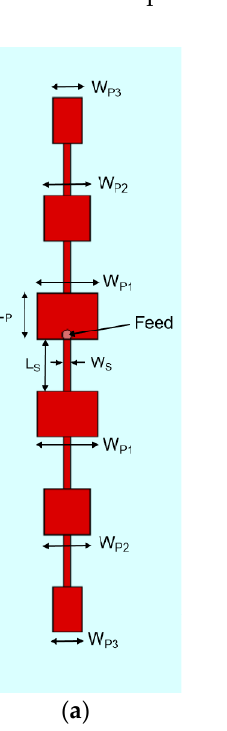
Figure 6. Measured (meas) and simulated (sim) sca tt ering parameters of the array antenna system. The ADSimPLL software [37] was used to design the chirp shape and the loop fi lter components. The PLL parameters (maximum, minimum, reference and phase detector frequency, VCO tuning law, etc.) were considered to be the ADSimPLL inputs. In partic- ular, since the PLL is controlled by a 16-time-scaled output frequency of the BGT24MTR11 board, the VCO central frequency is 24,125/16 = 1507.8 MHz, and the bandwidth 250/16 = 15.625 MHz. To reach a good compromise between the carrier phase noise and its se tt ling time, a loop bandwidth of 45 kHz with a phase margin of 47° was chosen. To this end, a 3-pole 4th-order loop fi lter was designed using the ADSimPLL software. The fi lter sche- matic is reported in Figure 7a, while its experimental prototype with surface mount de- vices (SMDs) is shown in Figure 7b. The fi lter transfer impedance was analyzed by using Microwave O ffi ce software by Cadence. Figure 8 shows a comparison between the simu- lated results and the measurements performed on the fi lter prototype from which an av- erage error of the order of 0.9 dB, corresponding to 11%, can be extrapolated. An excellent agreement between measured and simulated responses is evidenced. S c a tt e r i ng P a r a m e t e r s ( d B )